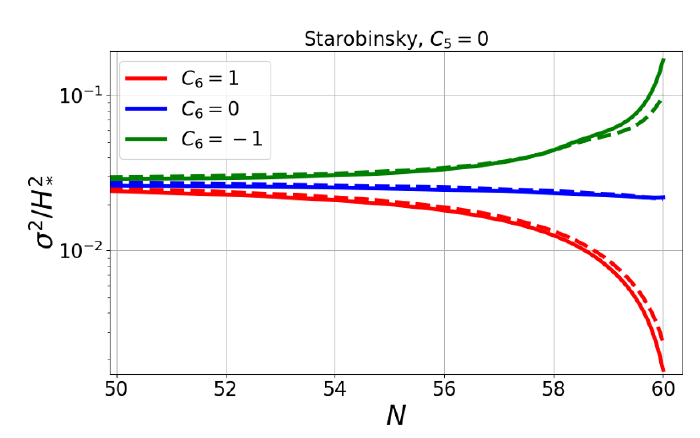
Figure 4. Impact of the dimension 6 derivative operator in (1.1) on the evolution of the variance of the Higgs (normalized to H ? ). The three curves are for Starobinsky in(cid:13)ation, (cid:24) = (cid:0) 0 : 03 and C 6 = 1 ; 0 ; (cid:0) 1, corresponding respectively to positive, vanishing and negative curvature of the (cid:12)eld space manifold. For each case the full versus dashed lines represent the evolution determined by the conventional Fokker-Planck equation (2.17) versus the phase-space one (2.27) discussed in 2.3.5. All curves are almost coincident for N (cid:20)